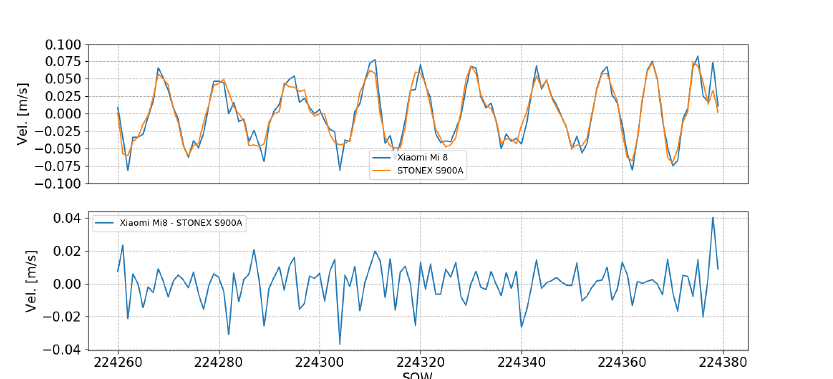
Figure 8. Time variation of 1D velocity for the epochs between 14:17:40 and 14:19:40 GPST on 2 April 2019. The plot shows variometric solutions for 10 Hz (blue) and 1 Hz (orange) measurements from the STONEX S900A and 1 Hz (green) measurements from the Xiaomi Mi 8.